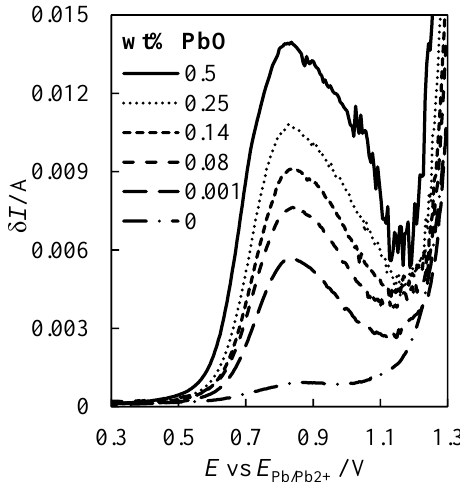
Figure 8. SWVs in the PbCl 2 melt with a different expected PbO content at a potential sweep rate of 0.1 V s −1 and a temperature of 520 °C.